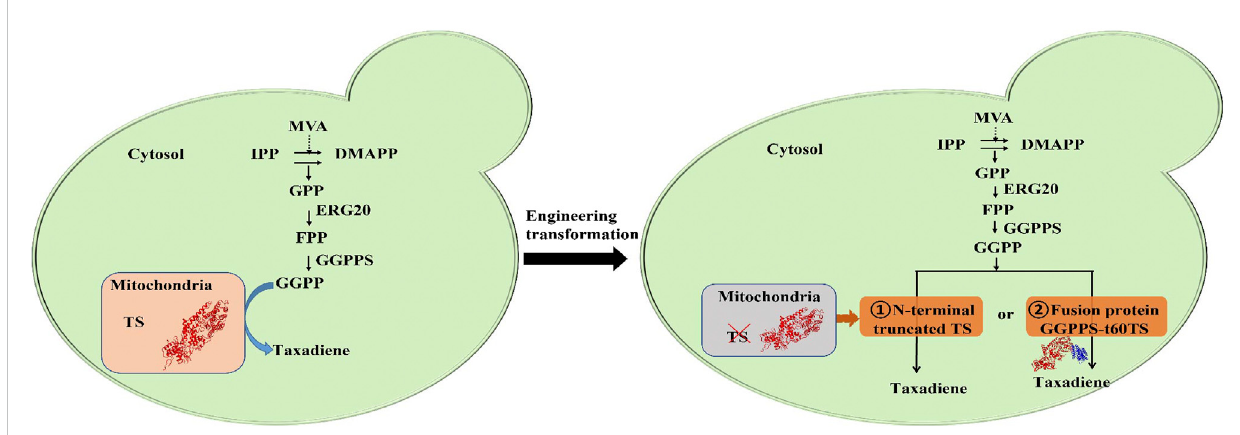
FIGURE 1 The biosynthesis pathway and metabolic engineering transformation of taxadiene. MVA, mevalonate; IPP, isopentenyl pyrophosphate; DMAPP, dimethylallylpyrophosphate; GPP, geranyl diphosphate; FPP,farnesyl diphosphate; GGPPS, geranylgeranyl diphosphate synthase; GGPP, geranylgeranyl diphosphate; TS, taxadiene synthase.